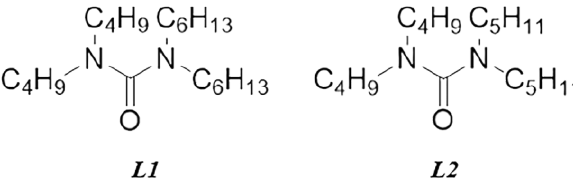
Figure 1. Structures of two novel